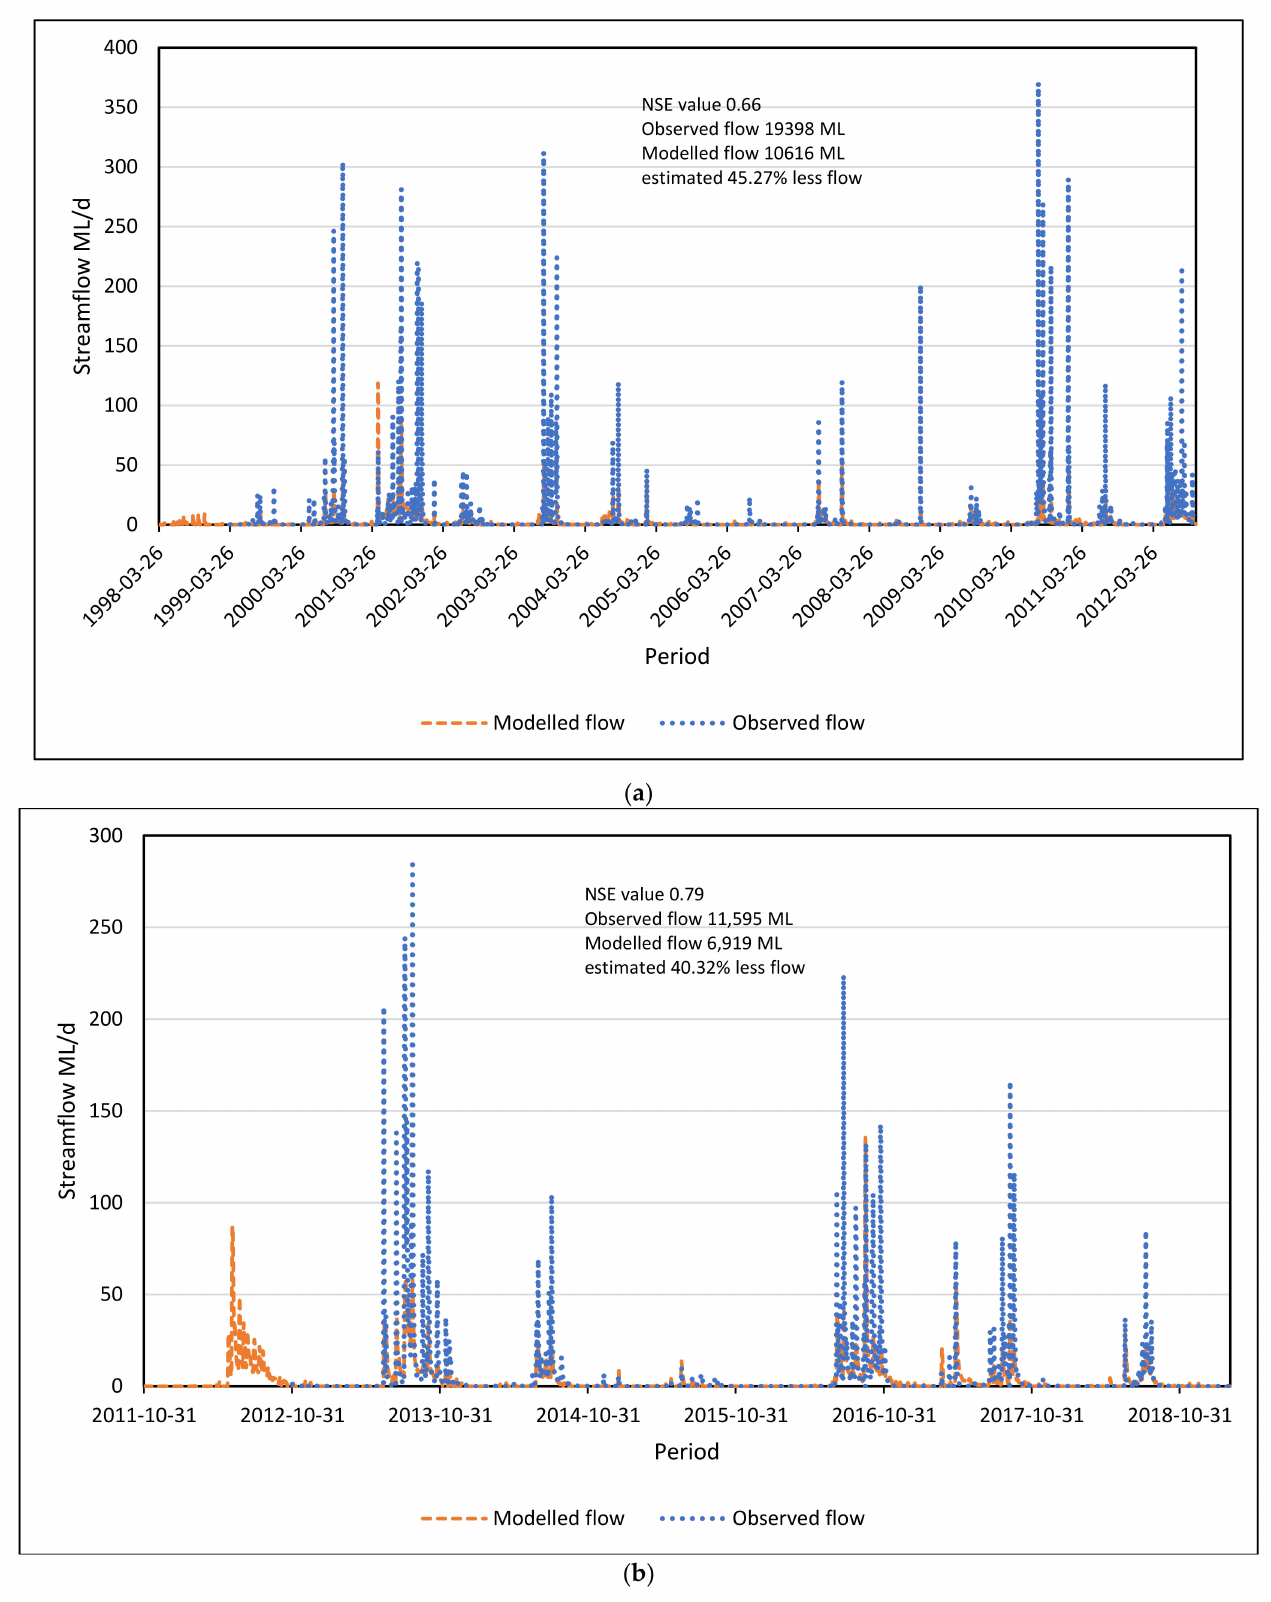
Figure 5. ( a ) Sacramento model calibration; ( b ) Sacramento model